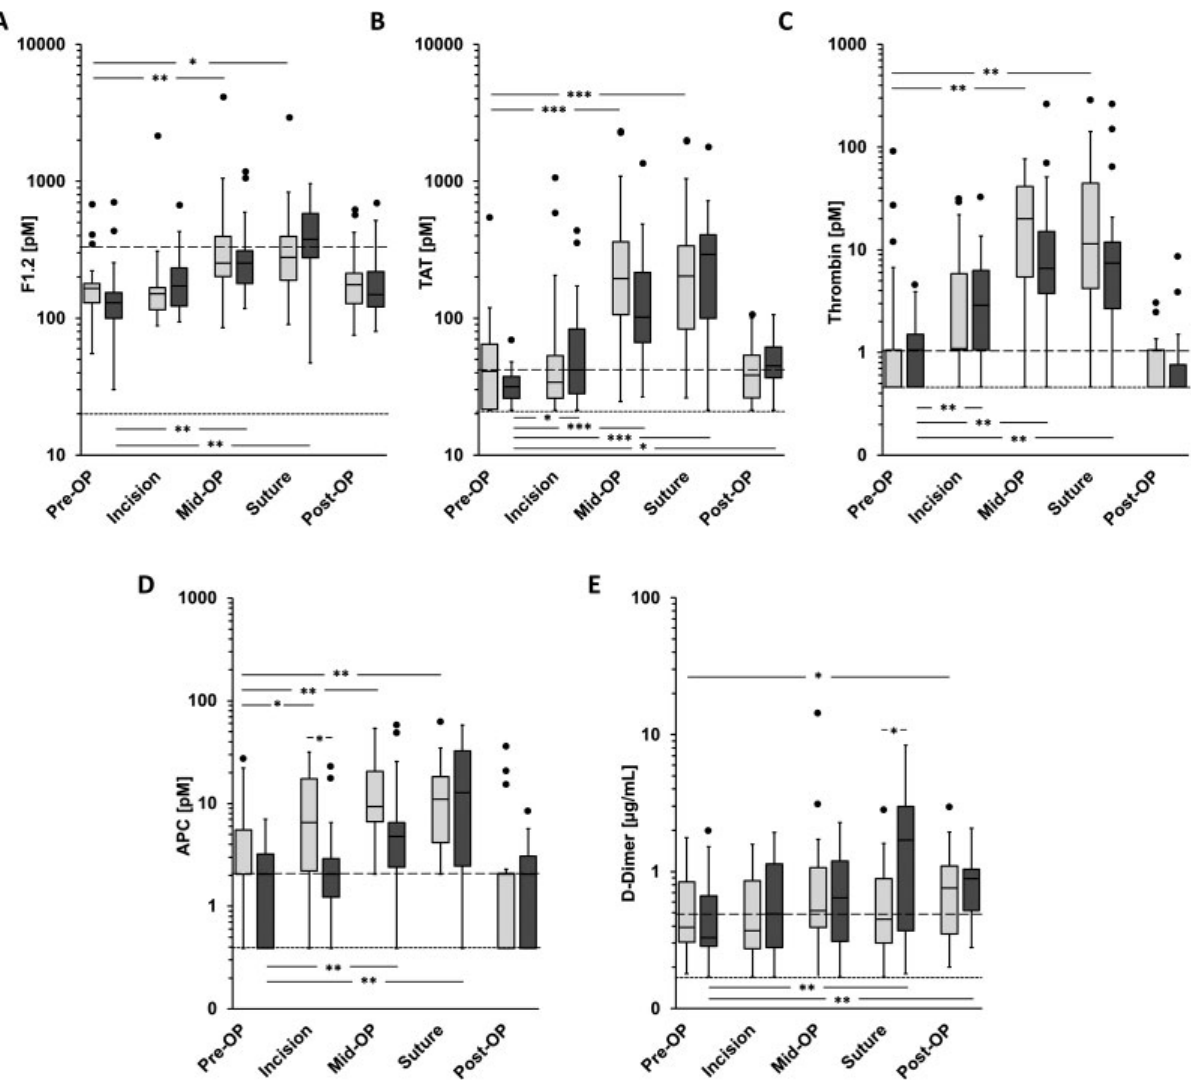
Fig. 2 Changes of in vivo coagulation biomarkers during orthopaedic surgeries. Plasma levels of the ( A ) prothrombin fragment (F1.2), ( B ) thrombin – antithrombin complexes (TAT), ( C ) thrombin, ( D ) activated protein C (APC), and ( E ) D-dimer were measured at the indicated time points in patients undergoing minor ( light gray boxes ) and major ( dark gray boxes ) orthopaedic surgeries. Data are expressed as box and whiskers plots with median, minimal and maximal values, interquartile ranges, and outliers. The long - and short-dashed horizontal lines represent the established upper limit of the normal ranges and the LLOQ or LOD (thrombin, APC) of the assays. Signi fi cant differences (cid:1) p < 0.05, (cid:1)(cid:1) p < 0.01, (cid:1)(cid:1)(cid:1) p <